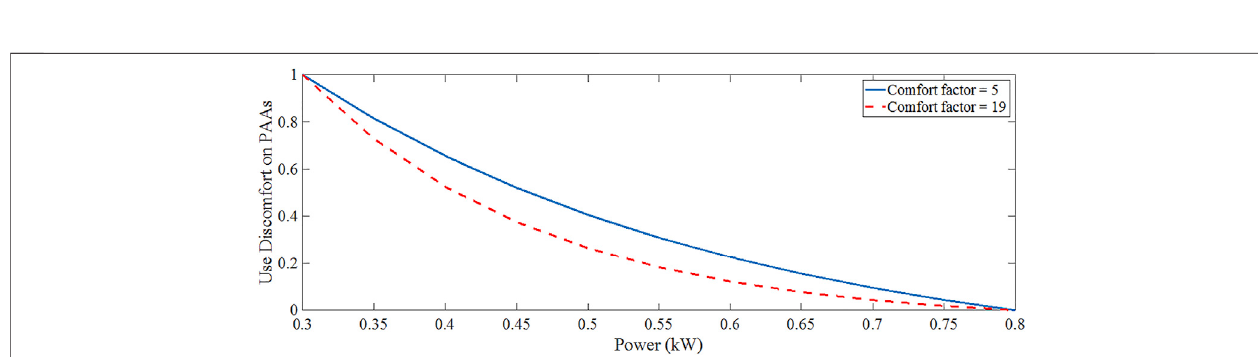
FIGURE 5 | Illustration of the variation of the occupant ’ s dissatisfaction degree on a PAA ’ s operation at one time slot ( P dsr i